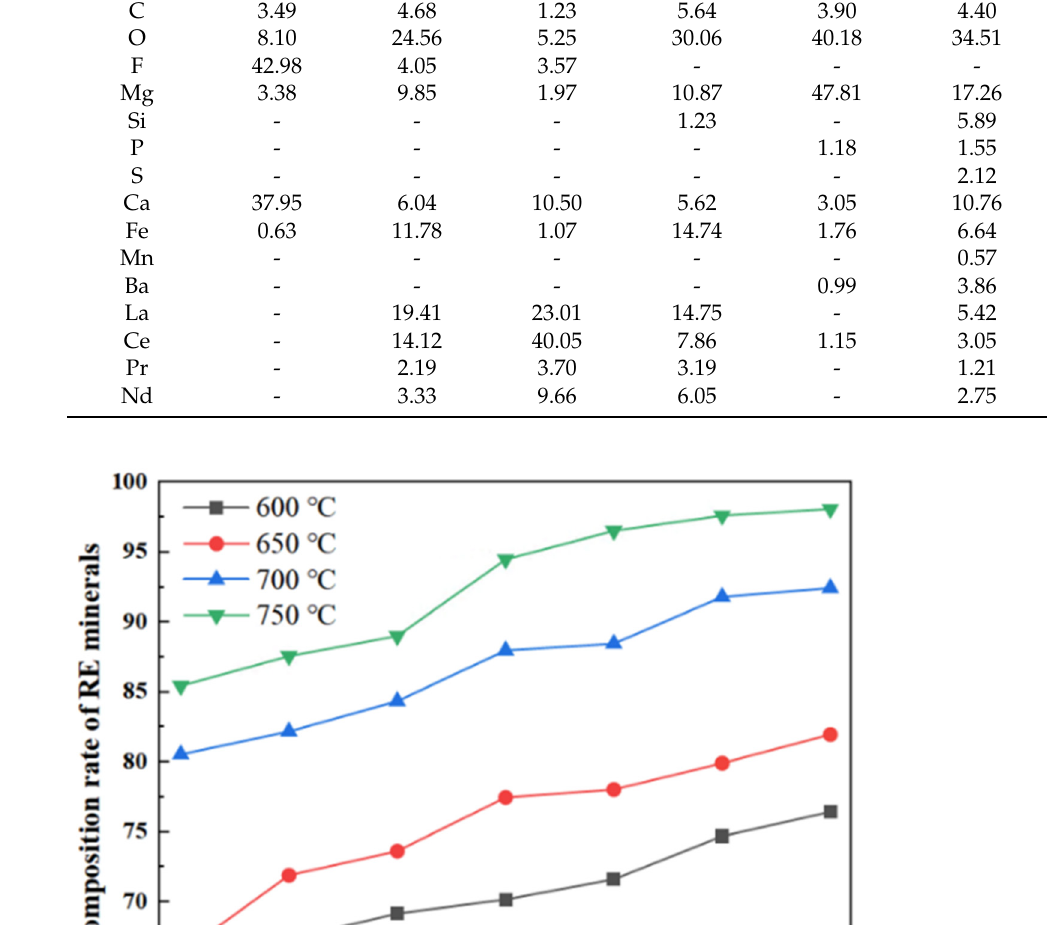
Figure 7. EDS analysis results of points in Figure 6.